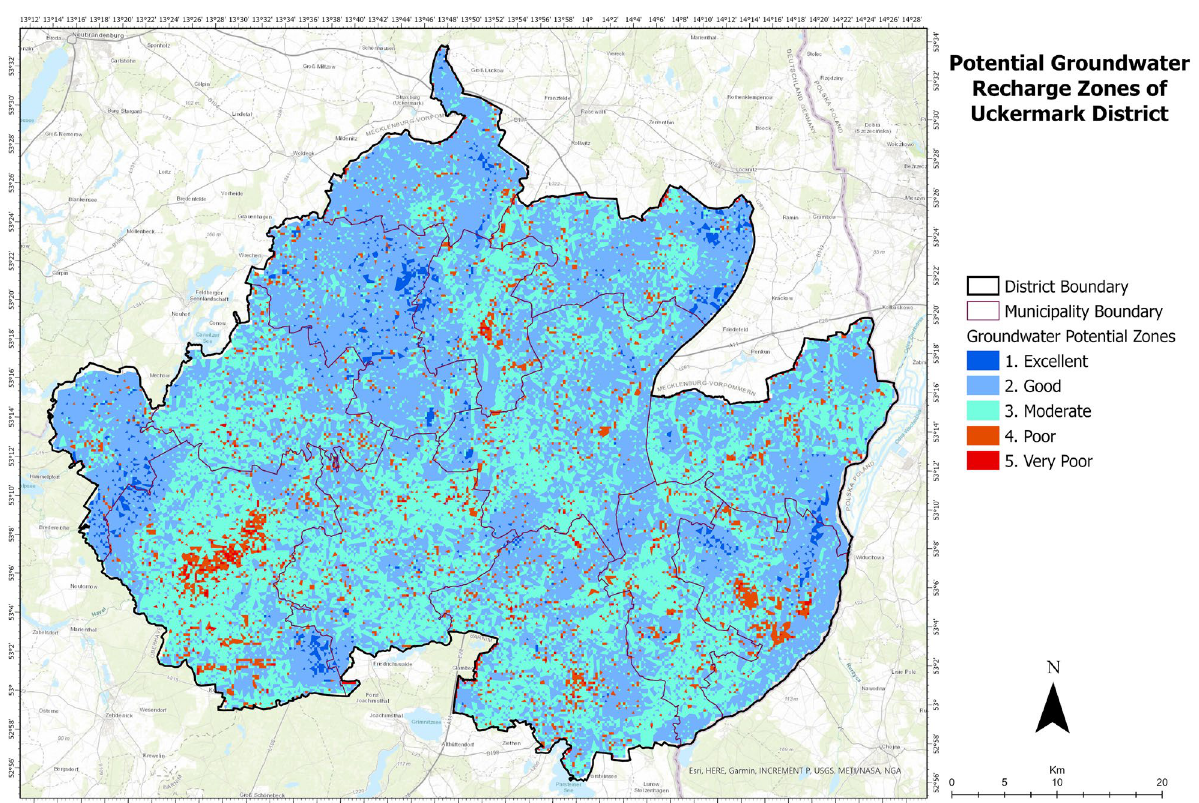
Figure 11. Potential groundwater recharge zones of Uckermark